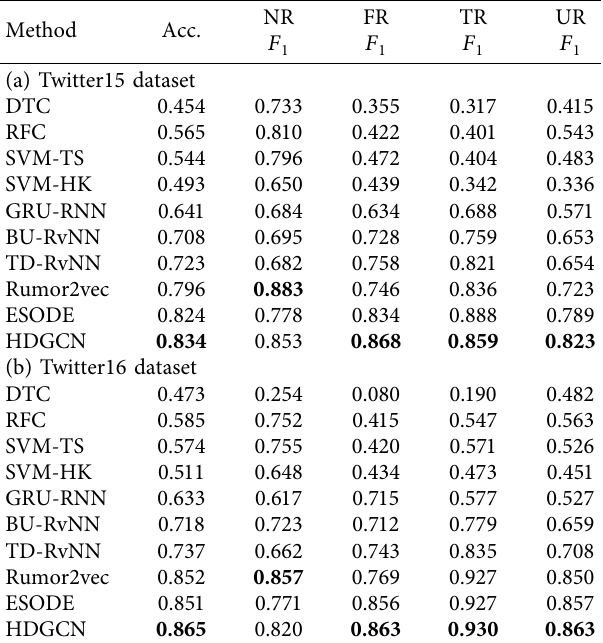
Table 3: Experimental results of rumor detection on Twitter15/ Twitter16. (NR: nonrumor; FR: false rumor; TR: true rumor;